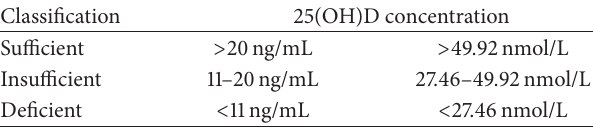
Table 2: Common classifications of circulating vitamin D